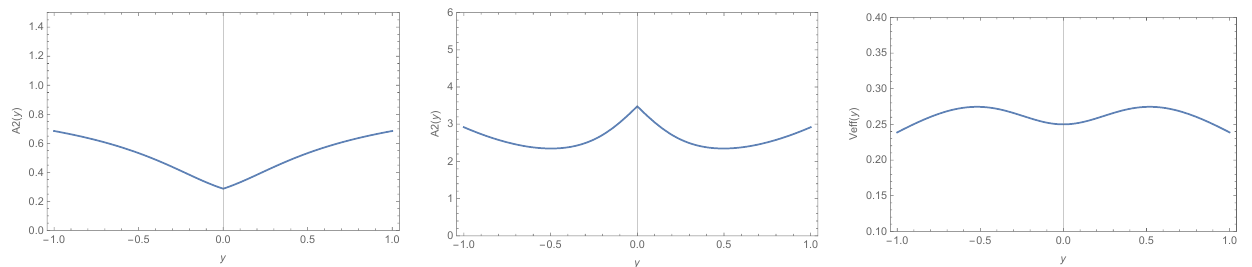
Figure 4. Plot of the function A 1 ( y ) , the radius r 1 ( y ) , and the effective potential, respectively, for the first wormhole solution, Equation (85). The values used for the parameters in this plot were: λ = 1, k = 3, m = 2, and L = 1.